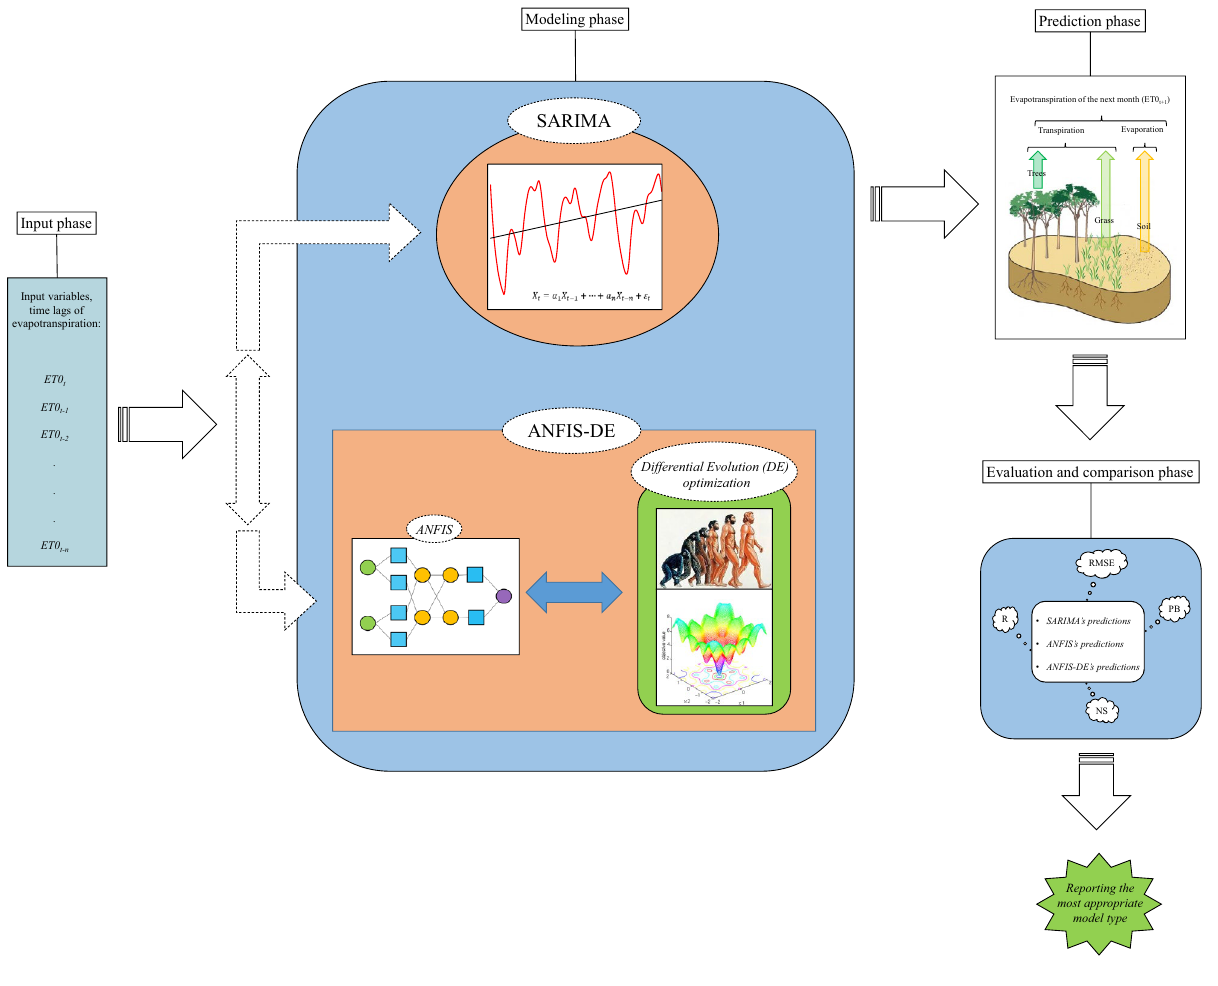
Figure 4. General flowchart of the evapotranspiration modeling, prediction, and evaluation processes.